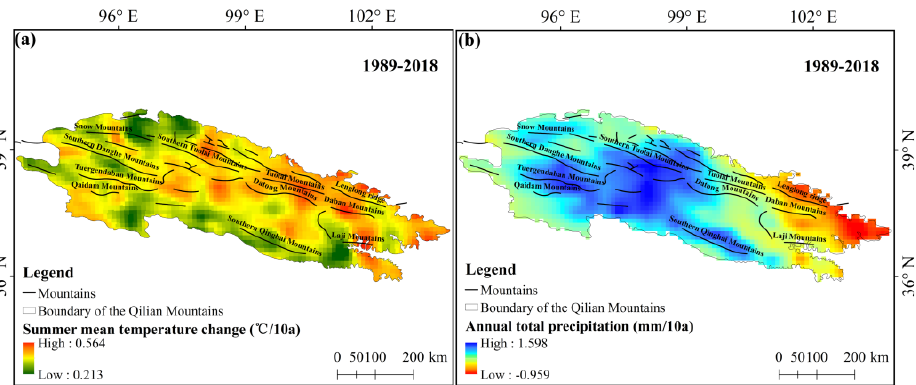
Figure 12. Changes of summer mean temperature ( a ) and annual total precipitation ( b ) in Qilian Mountains during 1989–2018.